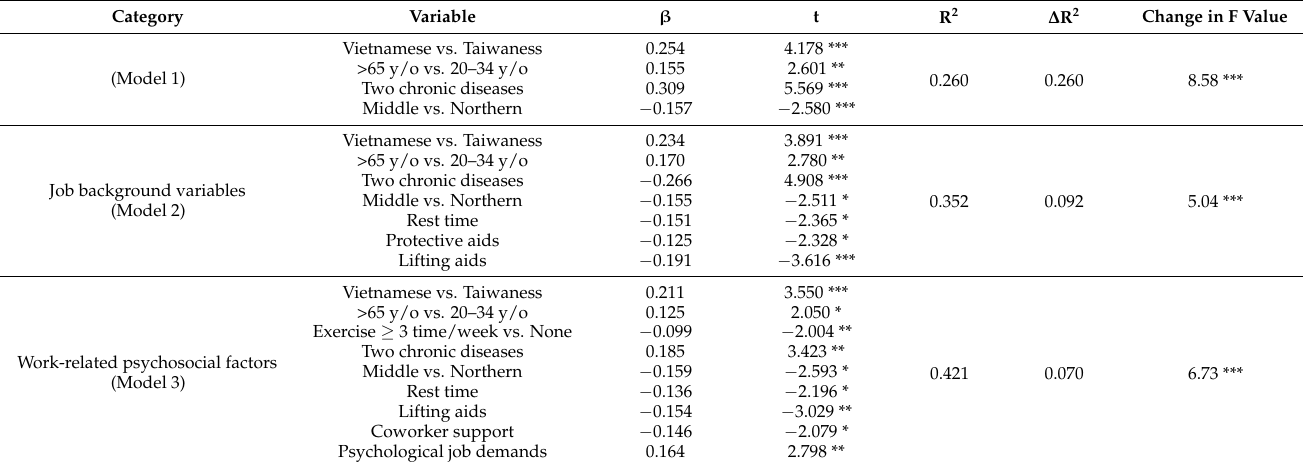
Table 4. Hierarchical analysis of factors affecting MSDs among nursing aides in LTCFs ( n =